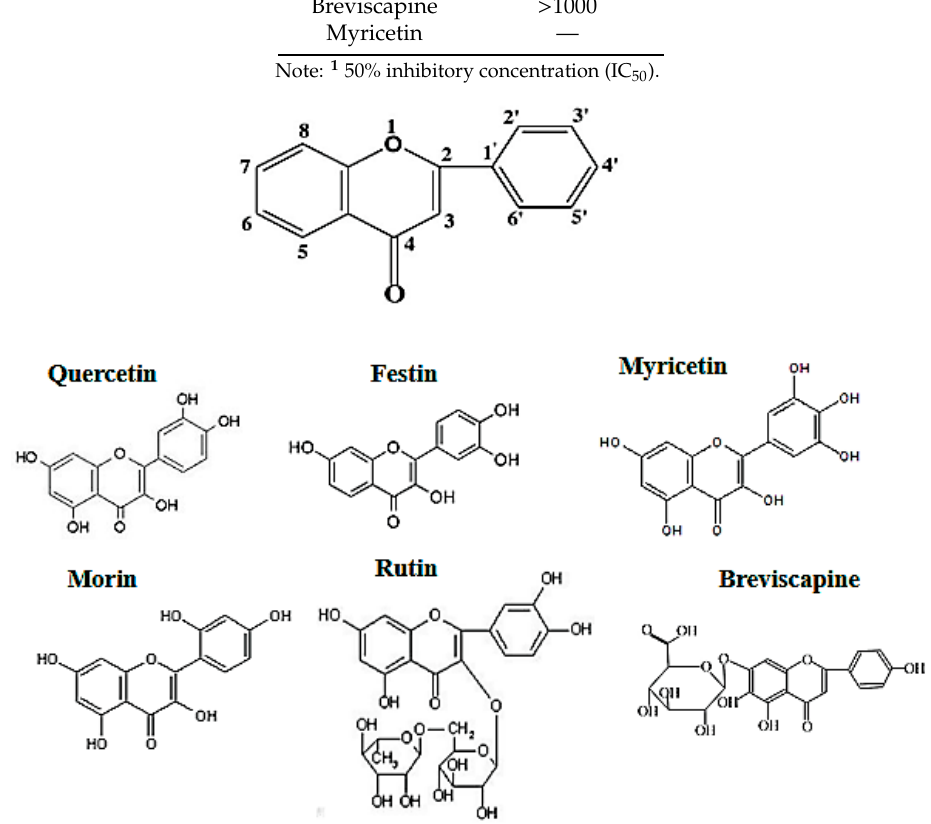
Figure 1. Flavonoid structure.